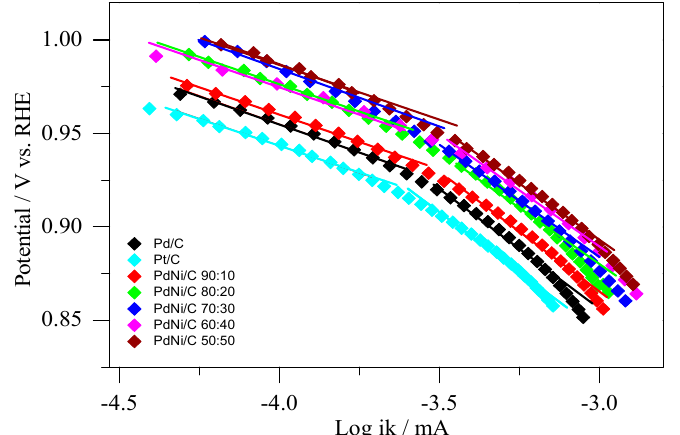
Figure 9. Tafel plots of kinetically controlled ORR currents on the Pd/C, Pt/C, and PdNi/C; 0 V vs. RHE = − 0.926 V (vs Hg/HgO/OH − ) at 2500 rpm was used to convert to the RHE (reversible hydrogen electrode) scale.